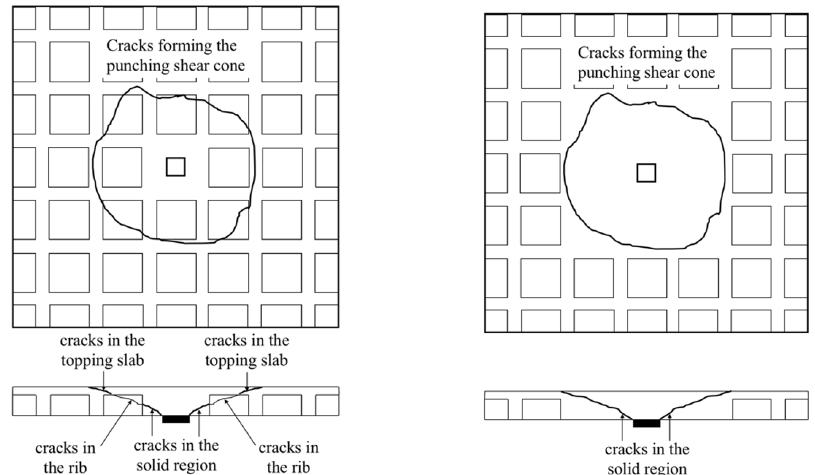
Figure 10. Cracks forming the punching shear cone in waffle flat slab with smaller solid area and larger solid area